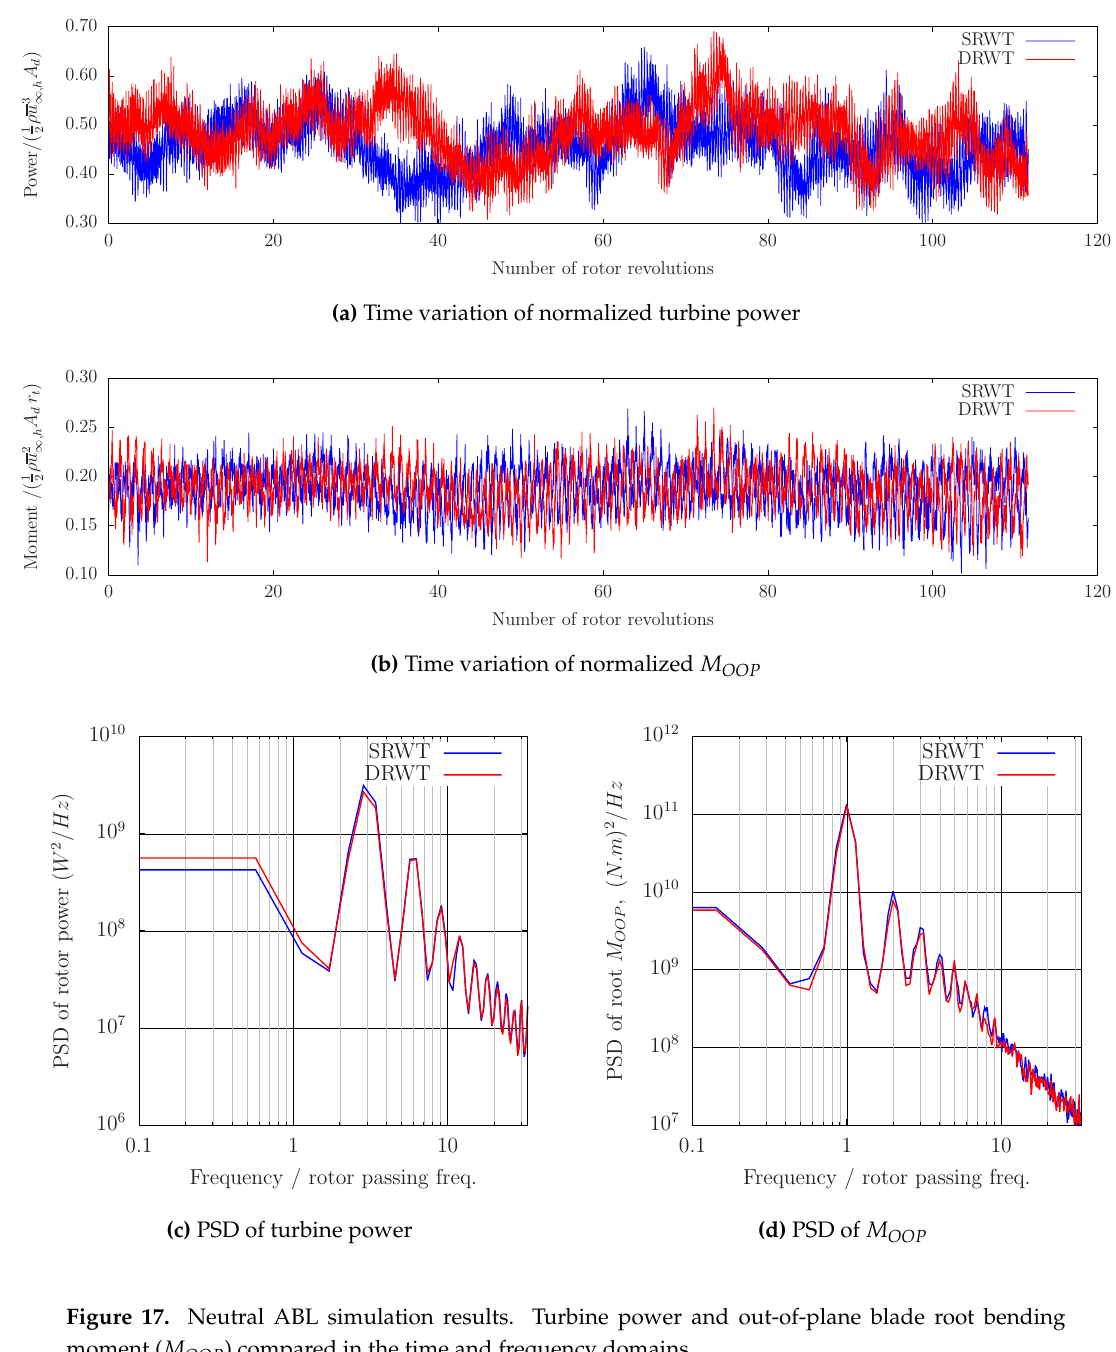
Figure 17. Neutral ABL simulation results. Turbine power and out-of-plane blade root bending moment ( M OOP ) compared in the time and frequency